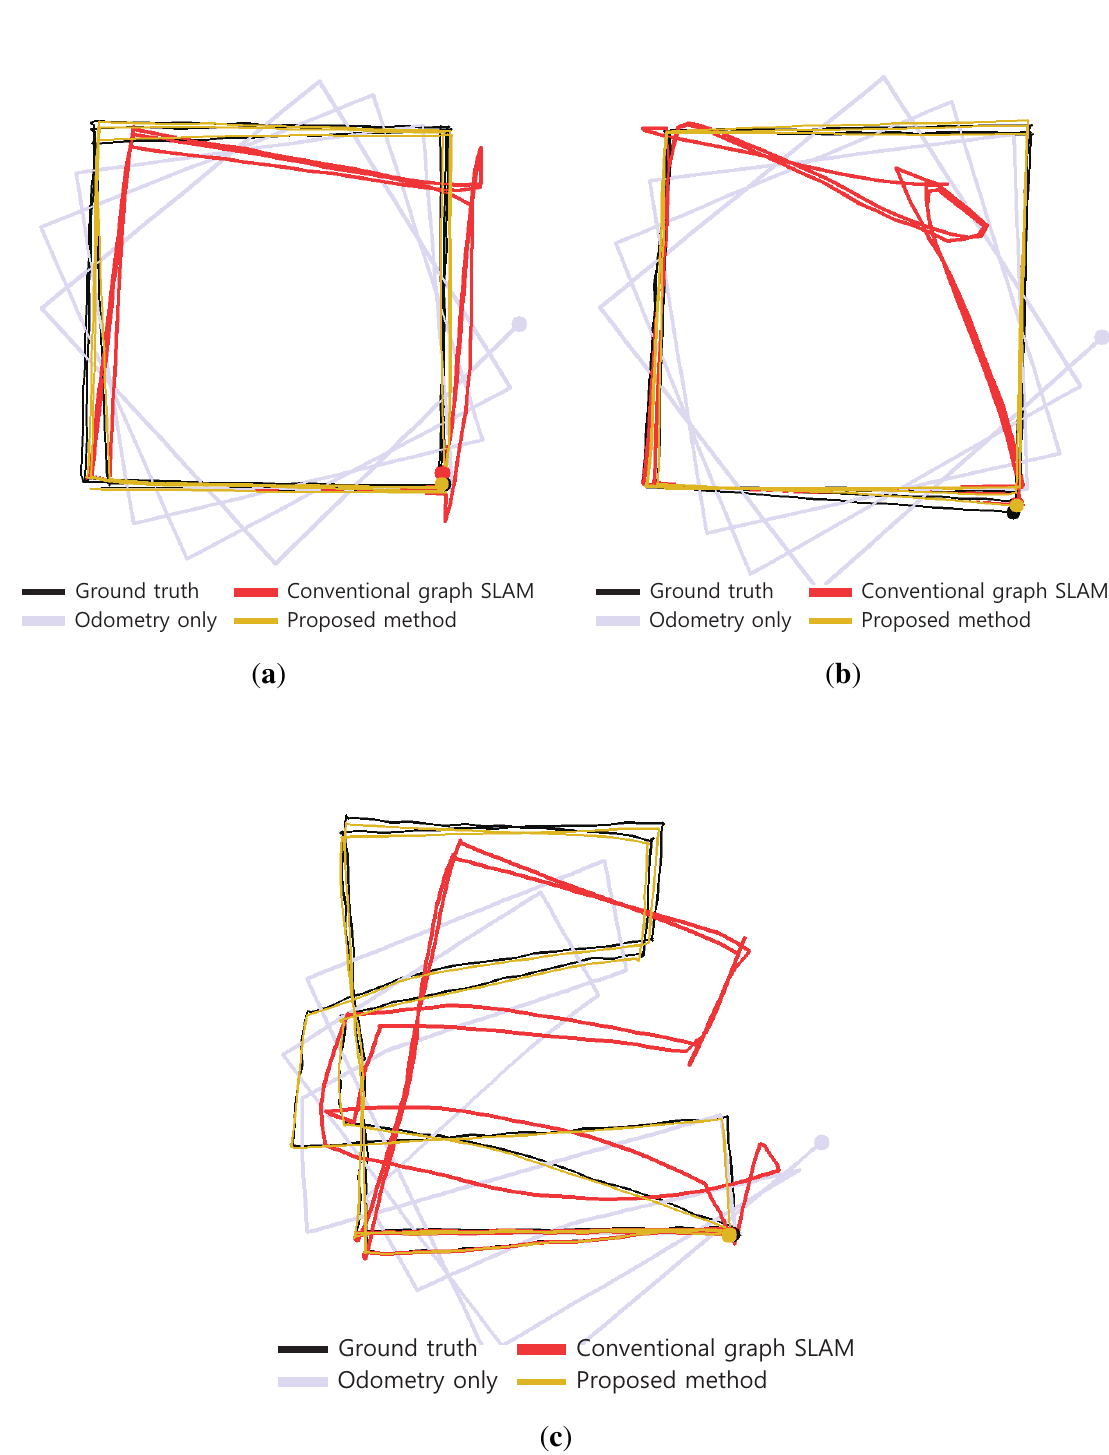
Figure 25. Four types of robot trajectories obtained in low dynamic experiments. ( a ) Experiment 1; ( b ) Experiment 2; ( c ) Experiment 3.